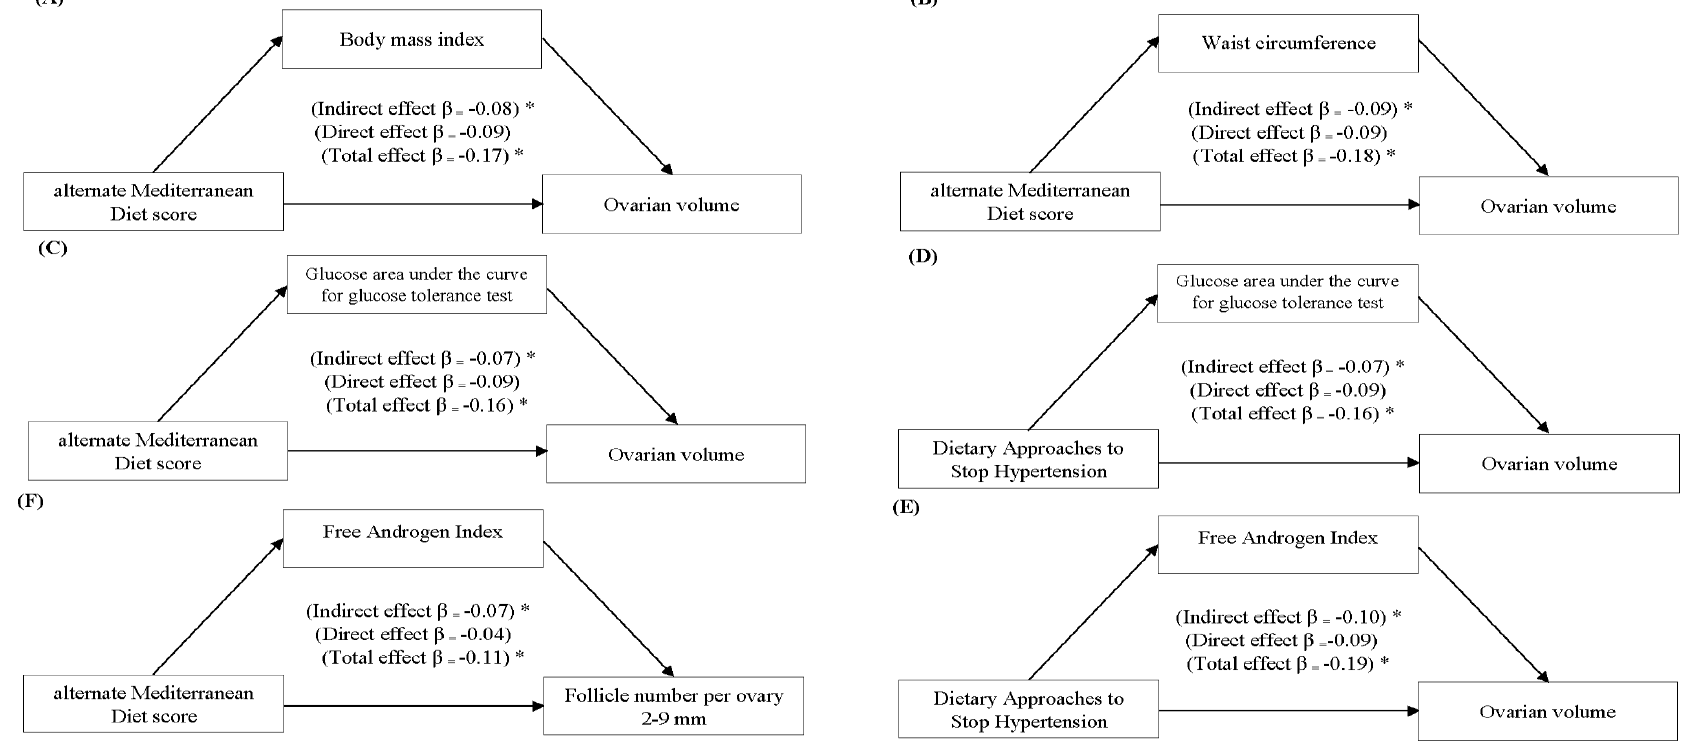
Figure 2. Simple mediation analyses demonstrating indirect associations between aMED and DASH scores and ovarian characteristics on ultrasonography for n = 109 women who provided optimal image quality with a reliable evaluation of ovarian volume ( Panels A to E ) and follicle numbers per ovary ( Panel F ). β is a standardized product of serial regression models on log-transformed variables. Standardized β can be interpreted as the expected standard deviation (SD) change in the OV and FNPO per 1 SD increase in dietary patterns through an individual mediator. Body mass index and waist circumference were designated as a proxy for obesity; glucose area under the 75 g oral glucose tolerance test curve for insulin resistance; and, free androgen index for hyperandrogenism based on the magnitude of the effect estimates in our statistical models shown in Supplementary data 2 (Supplementary Tables 1 and 2). All models are adjusted for age, race, and total energy intake. An asterisk above the effect estimate denotes a significant effect estimate ( p < 0.05).